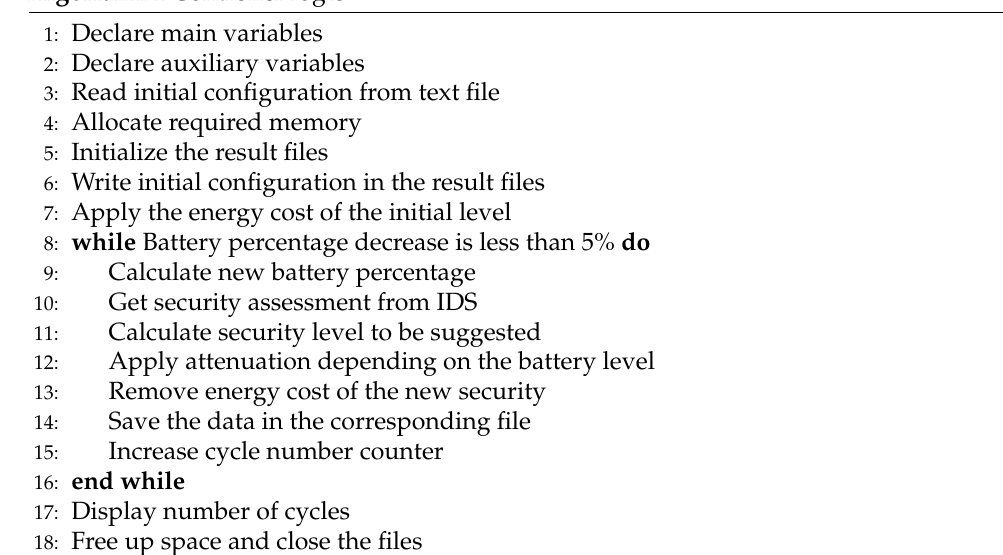
Algorithm 1 Controller logic.